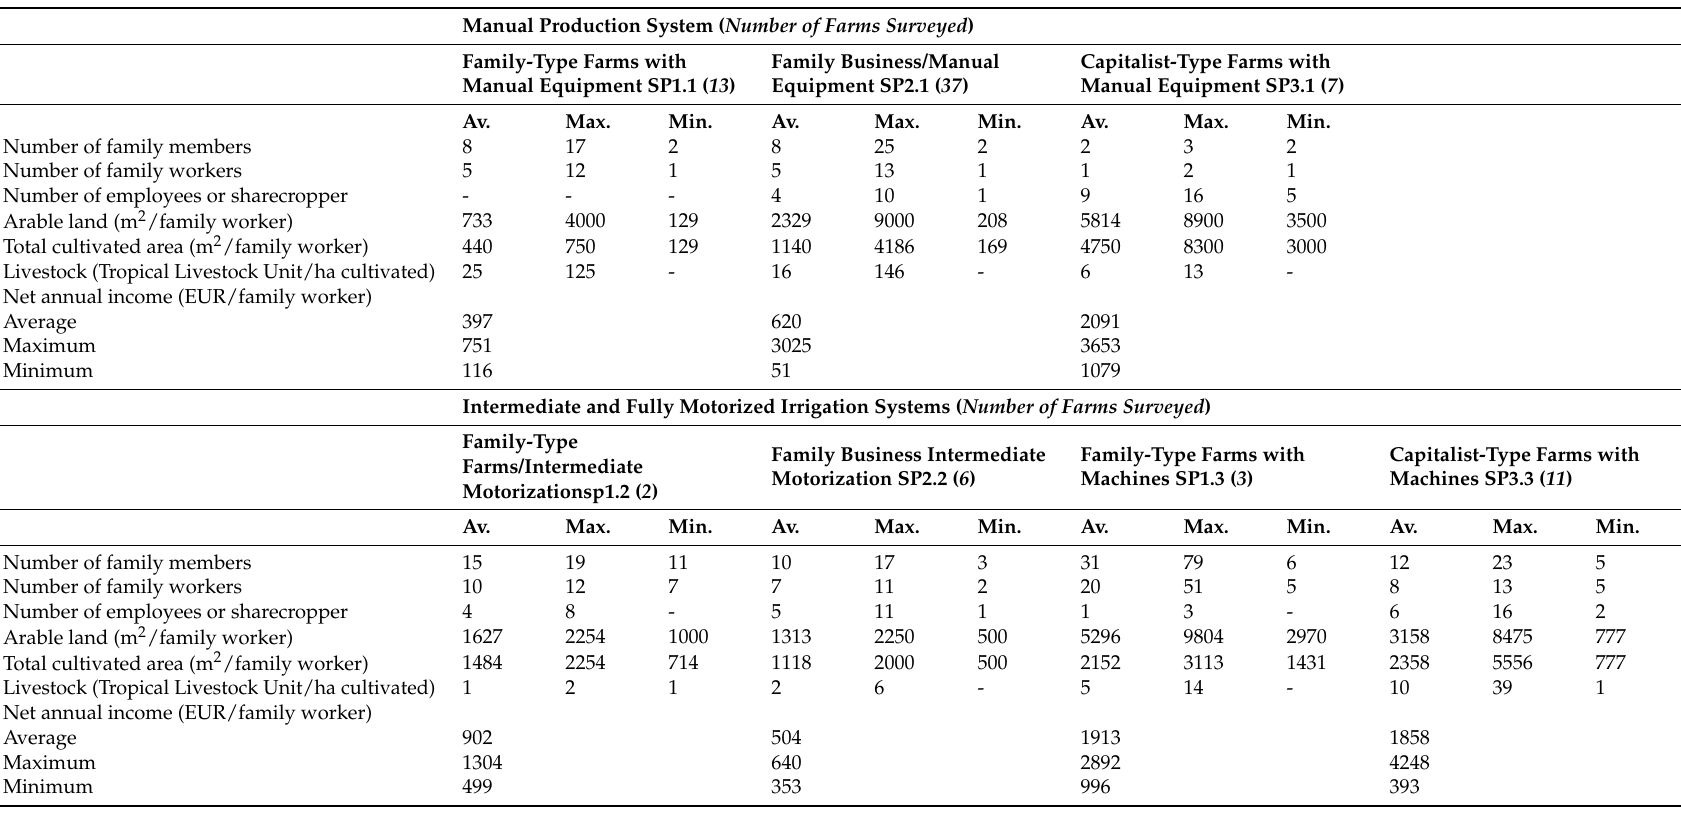
Table 7. Synthesis of the main features of the five main production systems identified ( N =